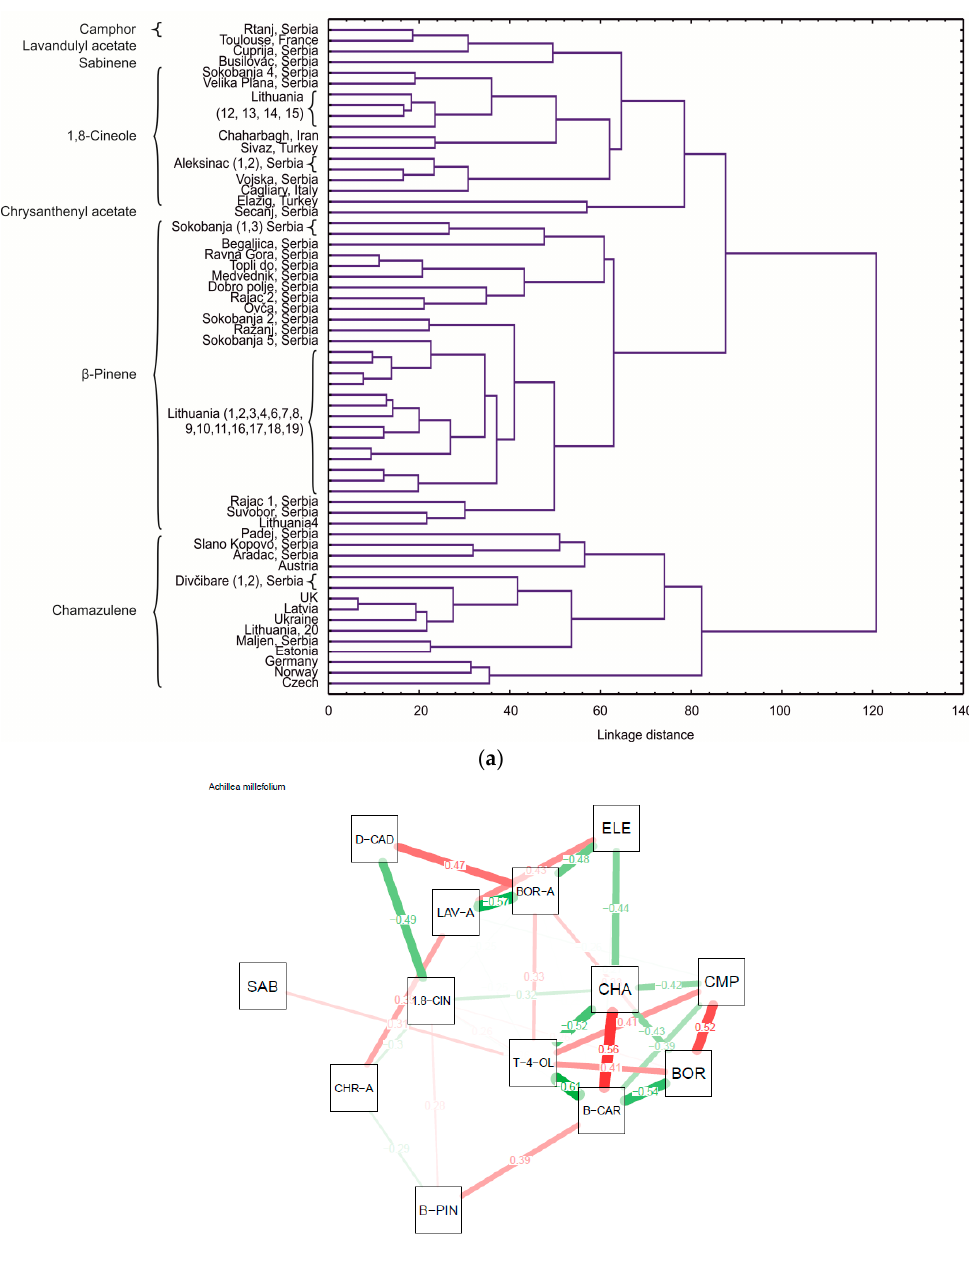
Figure 4. ( a ) Dendogram of the A. millefolium EO constituents from this study and from literature reports (the samples are marked according to Table 6); ( b ) correlation network based on A. millefolium